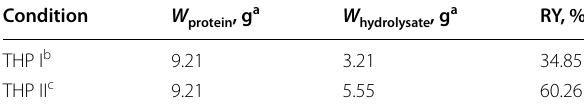
Table 2 Recovery yields under THP I and THP